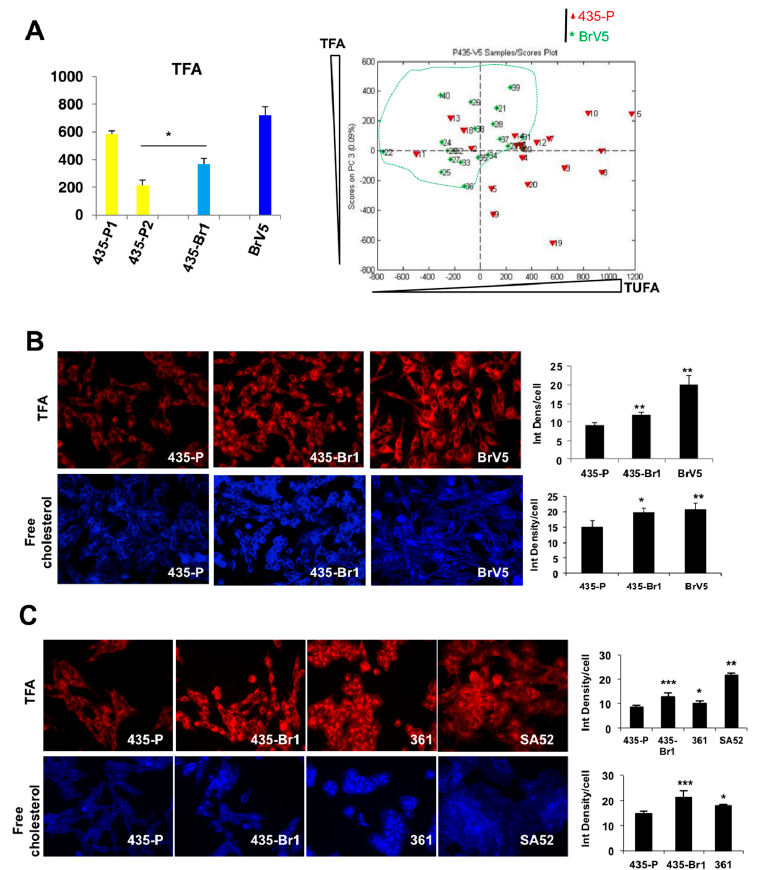
Figure 2. The lipid phenotype is conserved in other brain metastatic cell lines. 435-Br1 cells were obtained after five rounds of in vivo / in vitro passages to obtain a highly brain-specific cell line BrV5. ( A ) TFA were analyzed by Raman spectroscopy (left) and principal component analysis showing an enrichment in TFA content and a decrease in TUFA in BrV5 cells. Error bars represent SD of technical replicates (one representative of two experiments). ( B ) Nile red (top) and filipin (bottom) staining in 435-P and brain metastasis (BrM) cells 435-Br1 and BrV5 (40 × , one representative of three experiments). Integrated density was quantified with Image J and normalized to cell number (error bars represent SD of technical replicates, > 150 cells). ( C ) Nile red (top) and filipin (bottom) staining in 435-P and BrM cells 435-Br1, MDA-MB-361 and SA52. For Nile red, error bars represent SD of n = 2 (435-P, 361, SA52) or n = 4 (435-Br1) independent experiments. For filipin, pictures at 40 × , one representative of two experiments, > 150 cells analyzed. Error bars represent SD of technical replicates. Quantification was not possible for SA52 due to unclear nuclear visualization. For all panels, significance determined with t -test. * p < 0.05, ** p < 0.01, *** p <